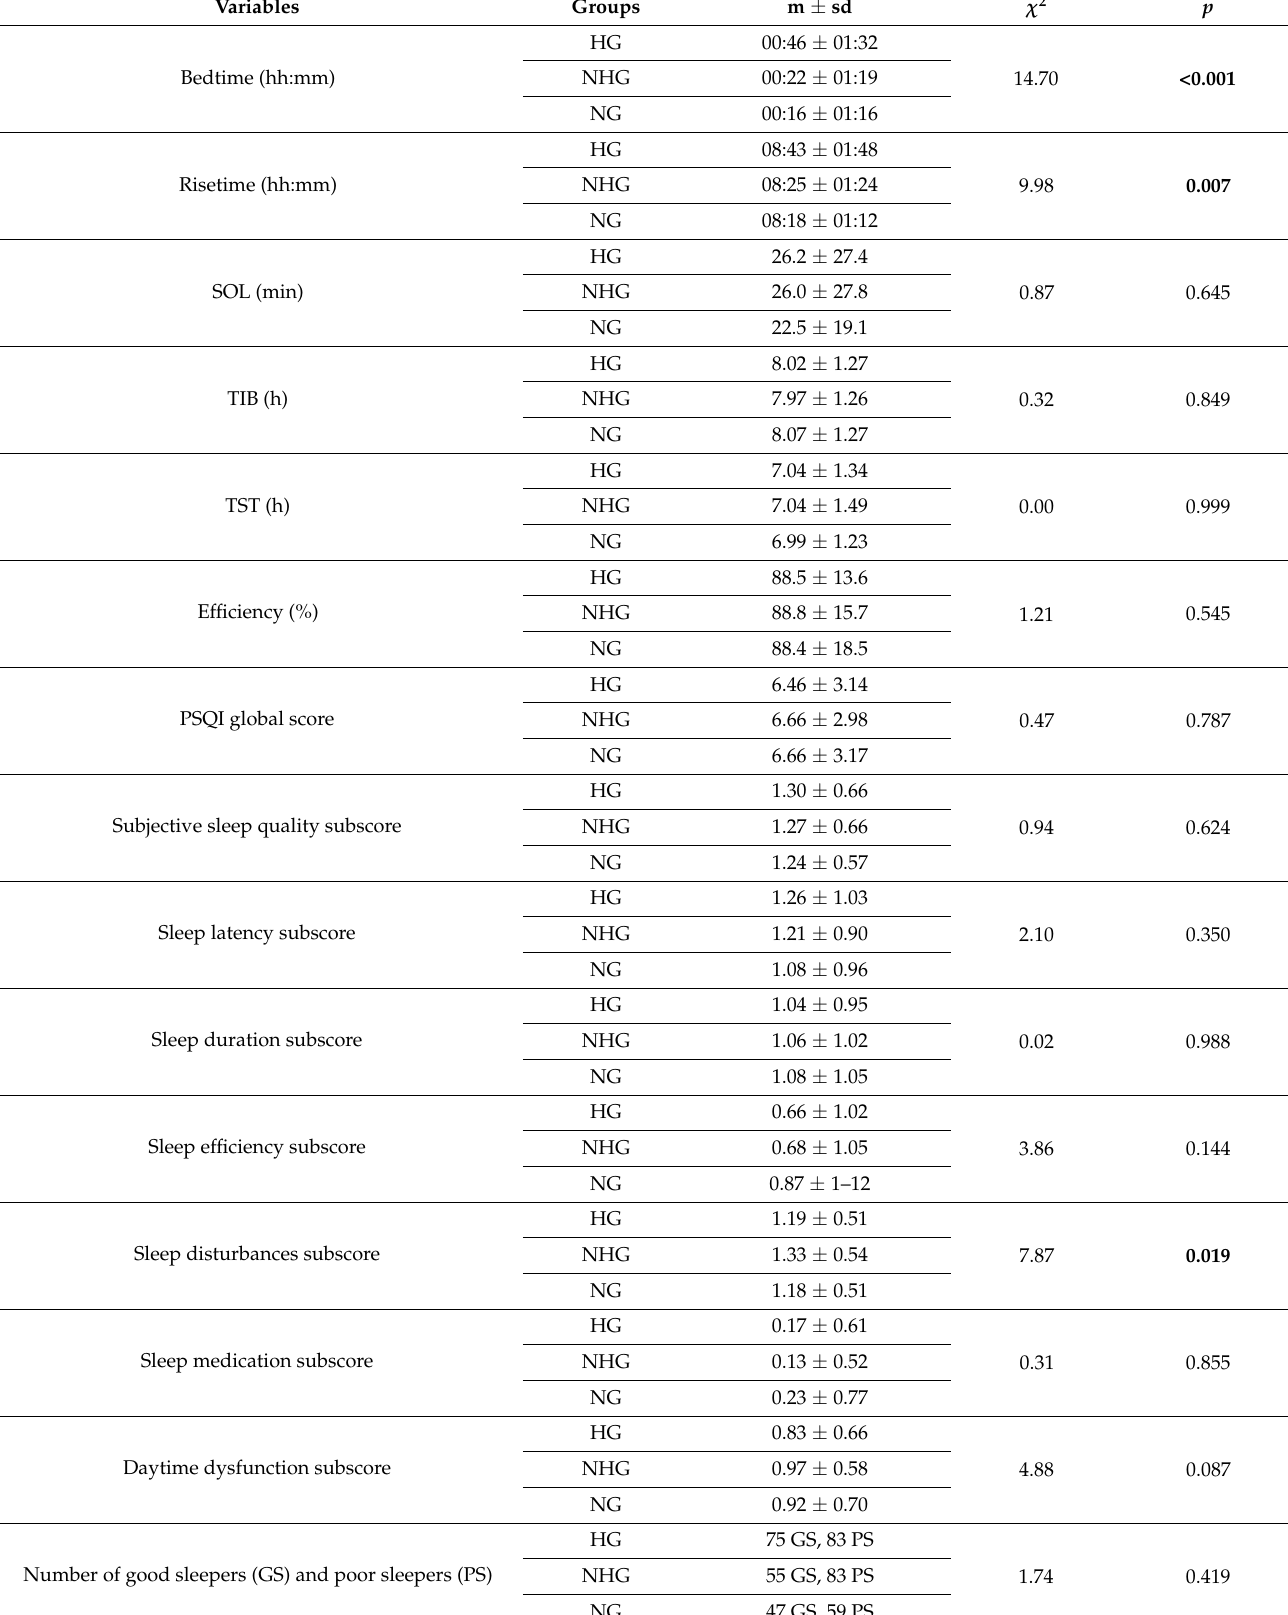
Table 2. Sleep variables, PSQI global score, and PSQI subscores in the three